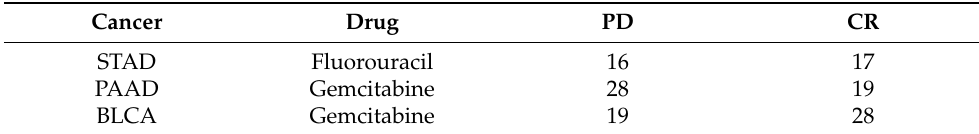
Table 2. Data summary of three drug-cancer pairs used in Validation Cohort II. Cancer Drug PD CR STAD Fluorouracil 16 17 PAAD Gemcitabine 28 19 BLCA Gemcitabine 19